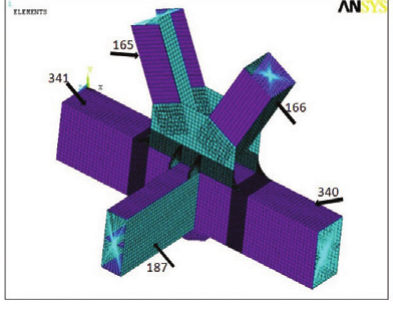
Fig. 5. Critical welded joint detail and finite element model